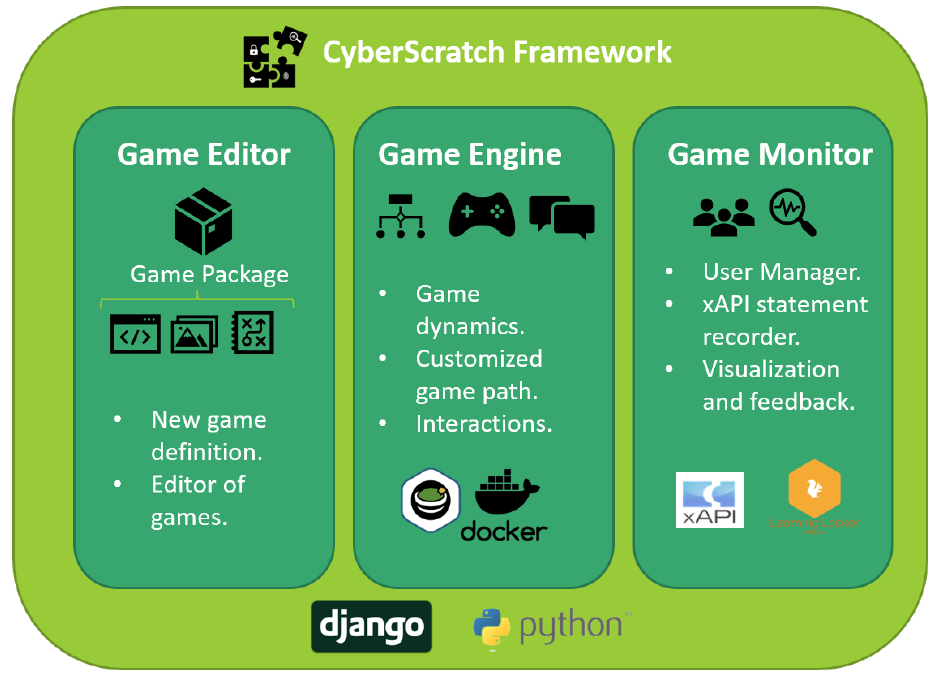
Figure 6. Proposed game architecture for the CyberScratch